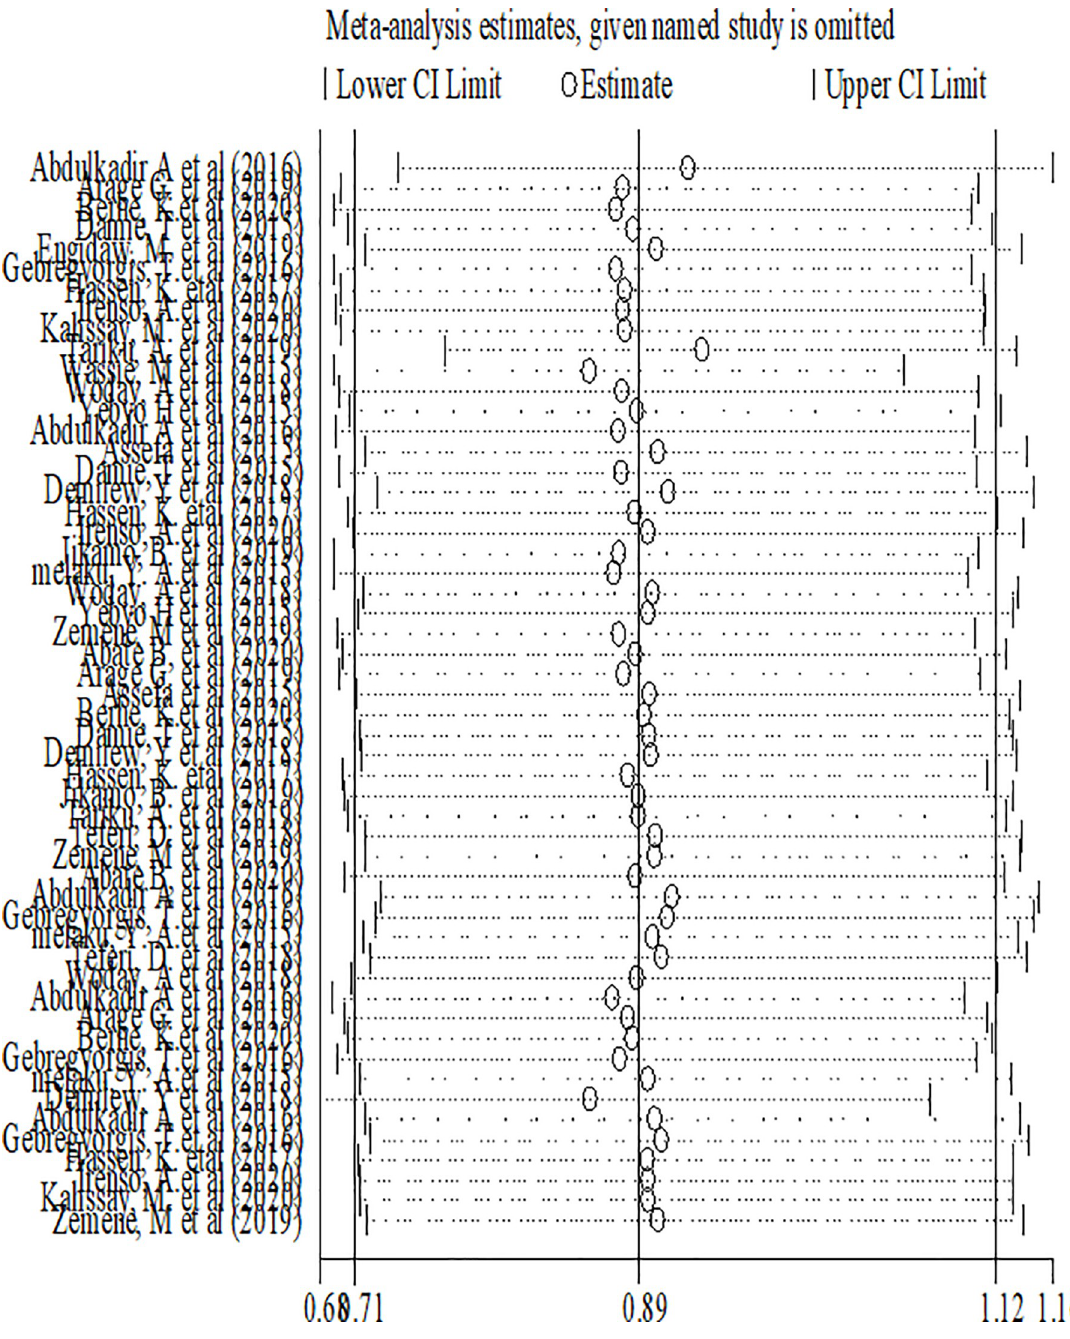
Fig 17. Sensitivity analysis of factors associated with stunting in